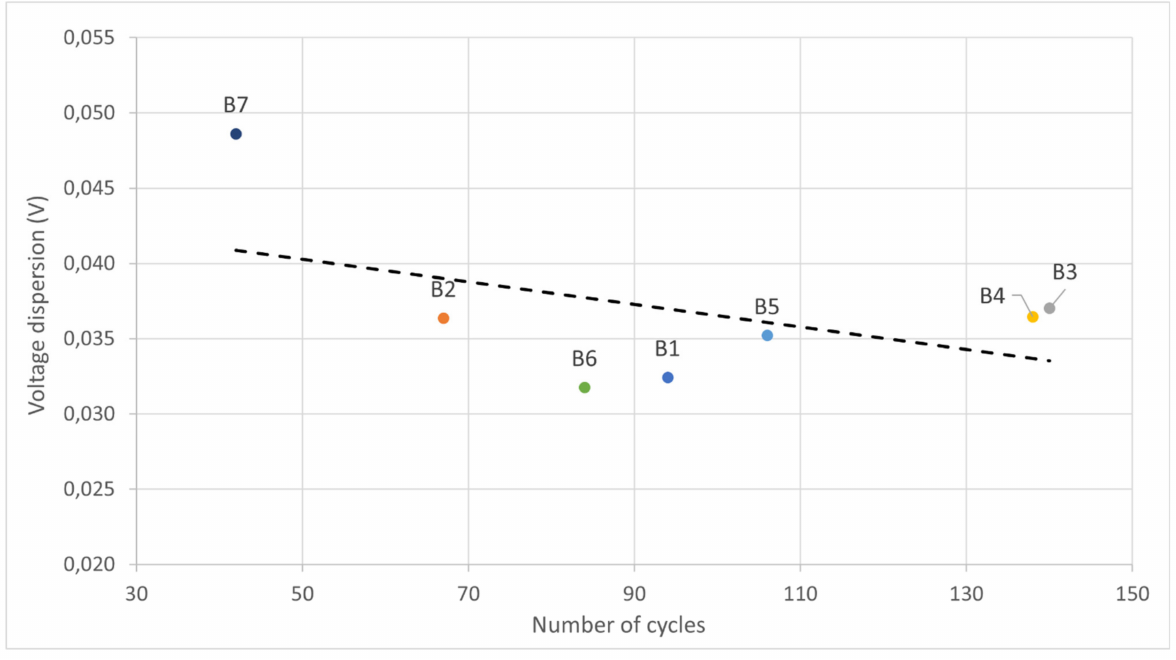
Figure 11. Voltage dispersion vs. cycle